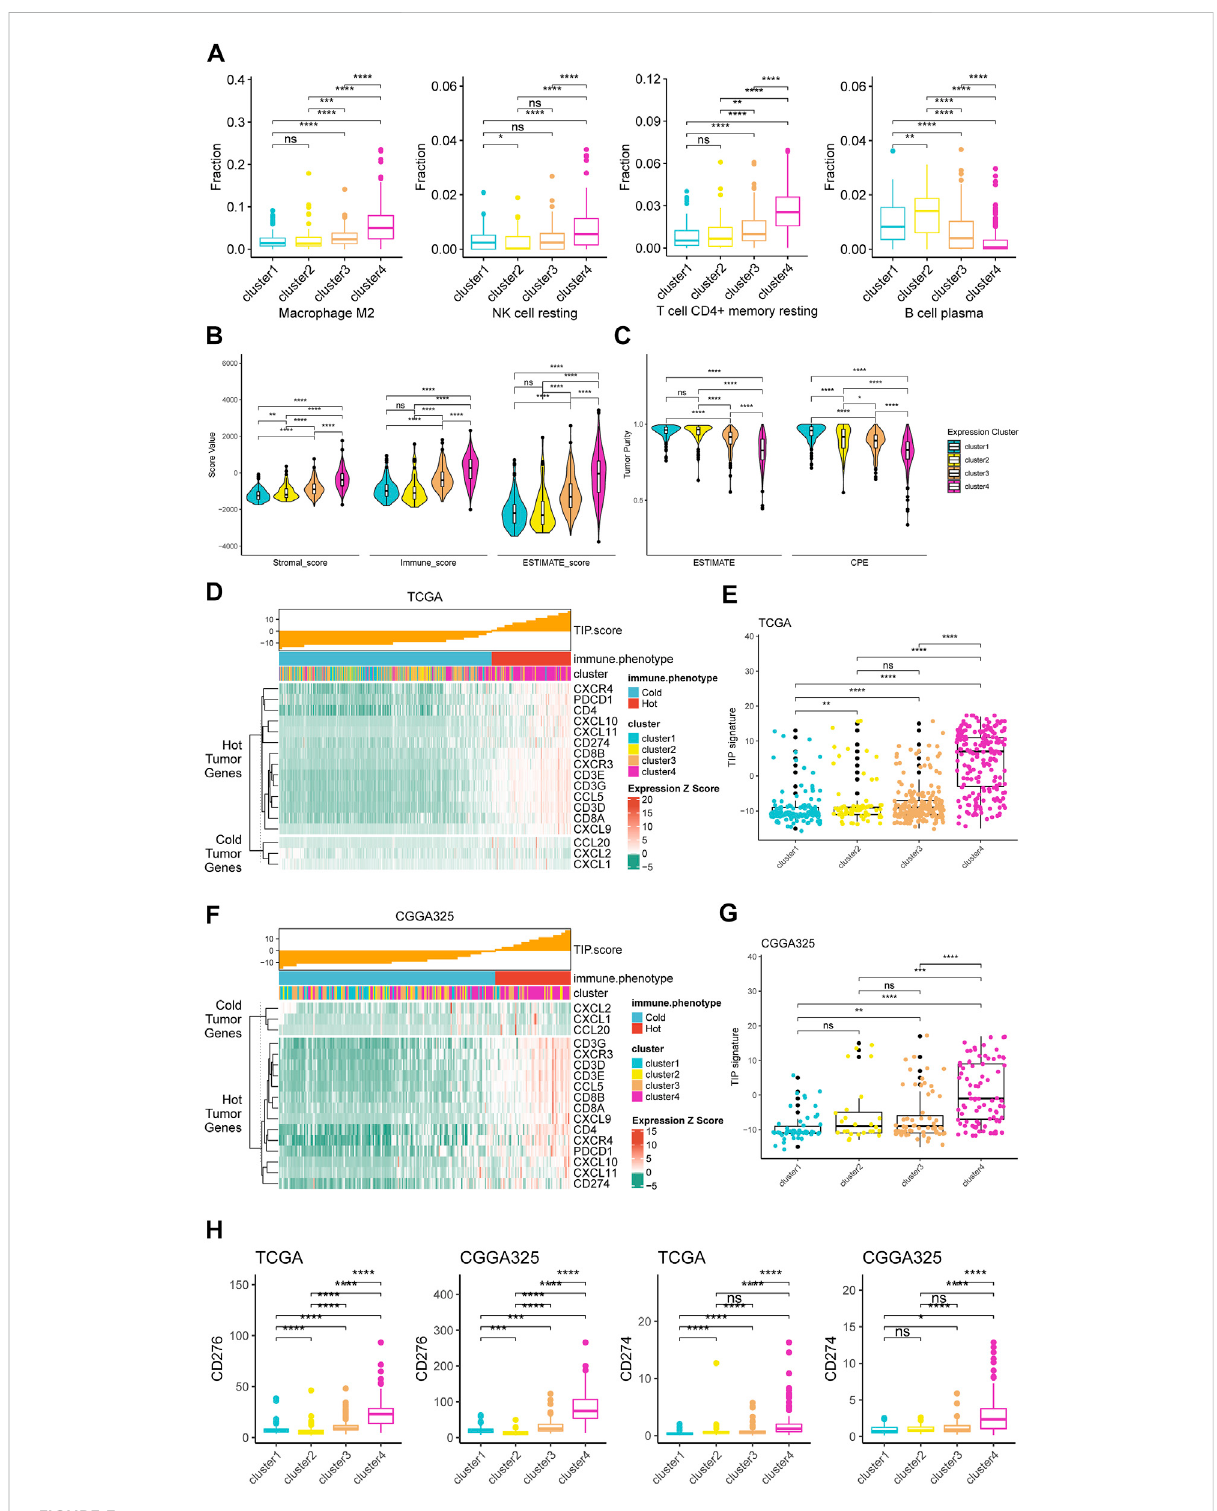
FIGURE 3 Different immunological landscapes of tumor microenvironment among four clusters. (A) Boxplots for in fi ltration fraction of four types of immunecellsbasedonCIBERSORTxinTCGAcohort. (B) Differencesinstromal,immune,andESTIMATEscoresamongfourclustersinTCGAcohort. (C) Difference intumor purity amongfour clusters inTCGA cohort. (D) TIP score and related gene expression heatmap among fourclustersin TCGA cohort. (E) DifferenceinTIPscore amongfourclustersinTCGAcohort. (F) TIPscore andrelated geneexpressionheatmap amongfourclusters in CGGA325 cohort. (G) Difference in TIP score among four clusters in CGGA325 cohort. (H) Differences in expression levels of CD274 and CD276 among four clusters in TCGA and CGGA 325 cohorts. * p < 0.05; ** p < 0.01; *** p < 0.001; **** p <